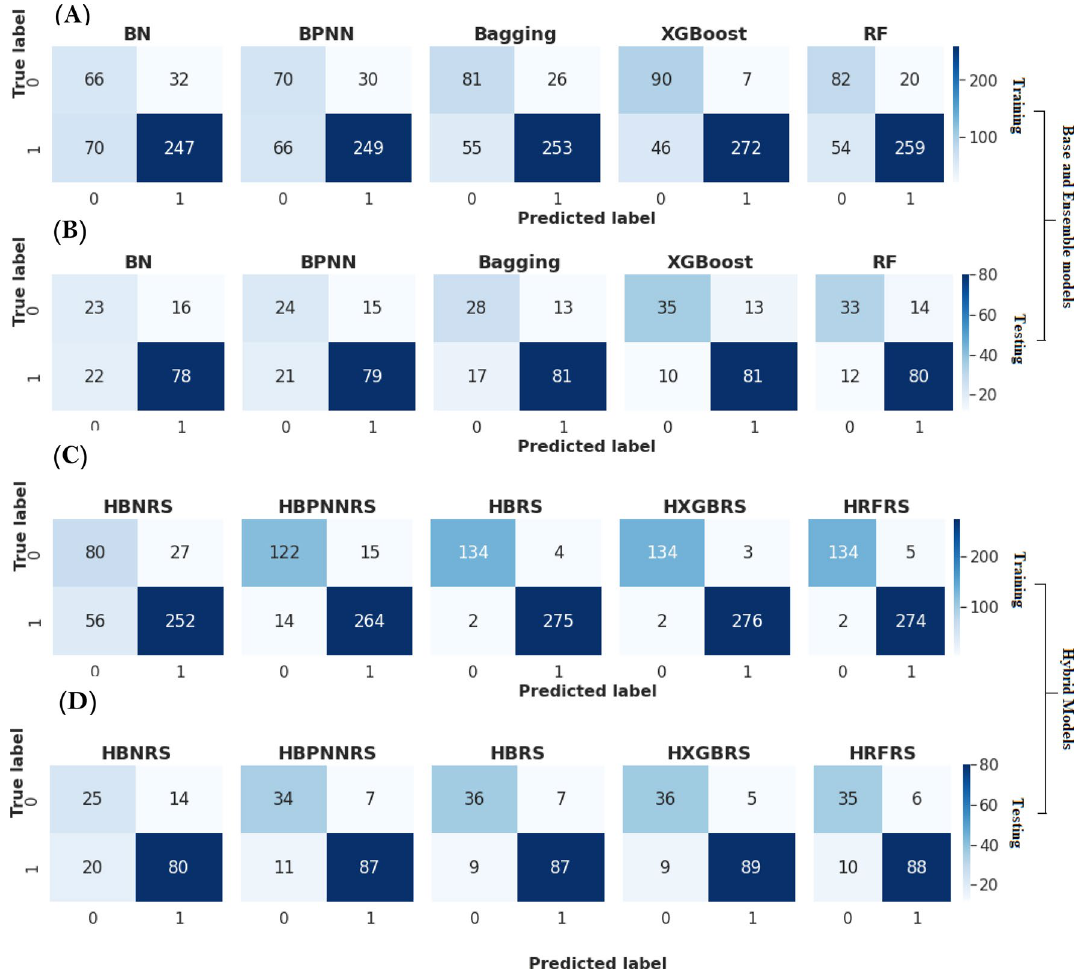
Figure 7. Confusion matrices showing classification results of landslides and non-landslides using base, ensemble and hybrid models based on training and testing dataset. It depicts the TN (top left), FP (top right), FN (bottom left) and TP (bottom right). ( A ) Represents the confusion matrix using base and ensemble models for training data. ( B ) Represents the confusion matrix using base and ensemble models for testing data. ( C ) Represents the confusion matrix using hybrid models for training data. ( D ) Represents the confusion matrix using hybrid models for testing